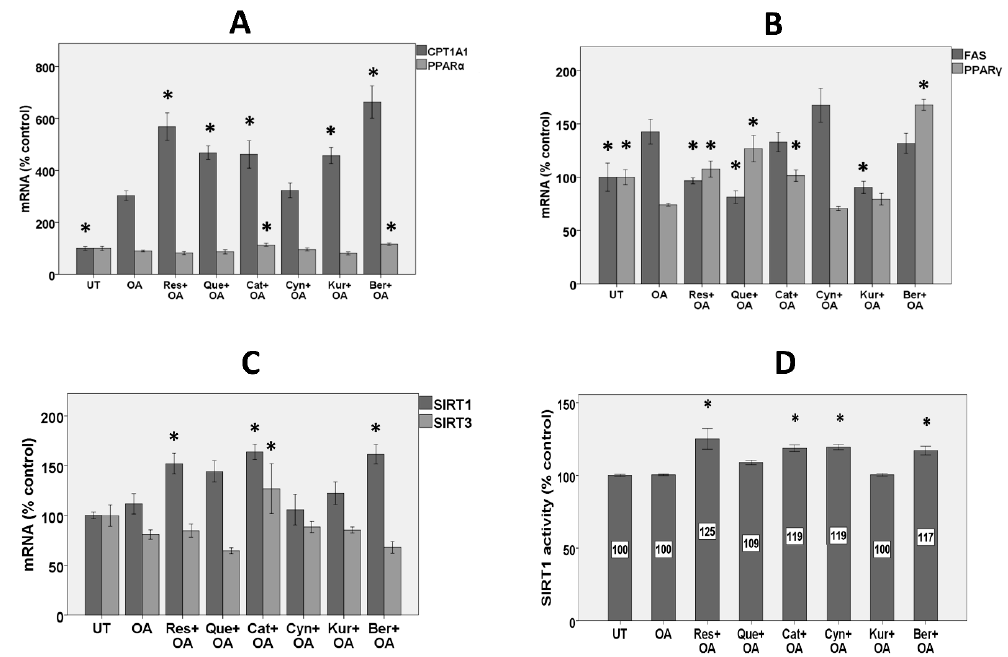
Figure 3. Effects on the genes controlling lipid metabolism and mitochondrial biogenesis, and SIRT1 activity. HepG2 cells were treated with 10 µM polyphenols for 2 h followed by 1.5 mM OA for 24 h in the presence of the polyphenols and mRNA expression for different genes as well as SIRT1 activity were measured. (A) Comparison of the effects of polyphenols on the expression of genes involved in fatty acid oxidation. (B) Comparison of the effects of polyphenols on lipogenic genes. (C) Comparison of the effects of polyphenols on genes involved in mitochondrial biogenesis (D) Comparison of the effects of polyphenols on SIRT1 activity. UT: untreated, Res: resveratrol, Que: quercetin, Cat: catechin, Cyn: cyanidin, Kur: kuromanin, Ber: berberine. For SIRT1 activity, data are normalized to protein concentration. Untreated cells were set at 100% and data are presented as % of the untreated cells. The Figure represents means ± SEM of two independent experiments with three wells of cells in each experiment. (*) Significantly different (P<0.05) from the OA alone condition.